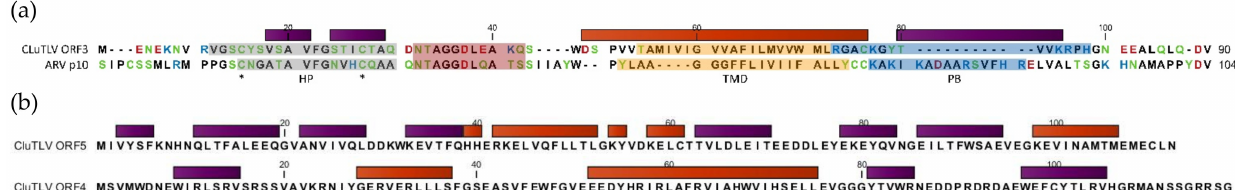
Figure 5. Characteristics of CLuTLV ORF3, 4 and 5 encoded proteins. ( a ) Alignment of ORF3 encoded protein against avian orthoreovirus (ARV) p10 (GenBank accession no. AKH03114). Conserved domain in red shade. Predicted transmembrane domains (TMD) shown in orange shade, other hydrophobic path (HP) in grey shade. Asterisks mark conserved cysteines. Polybasic motif (PB) in blue shade. Amino acids are color coded on polarity; Black non-polar, green polar uncharged, red polar acidic, blue polar basic. Predicted α -helices (red box) and β -strands (purple box) are included for CLuTLV. ( b ) Secondary structure predictions for CLuTLV ORF4 (i) and ORF5 (ii) encoded proteins given as described for ORF3 in ( a ) and other viruses in Figure